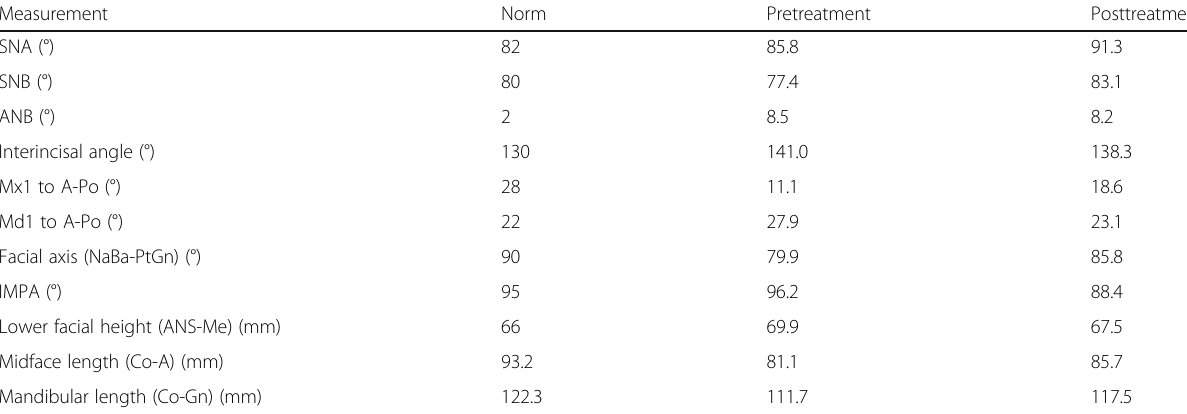
Table 2 Cephalometric measurements patient 2